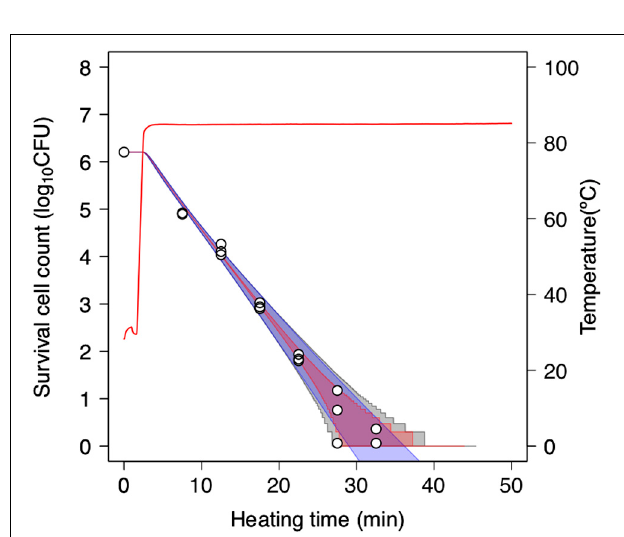
FIGURE 8 | Comparison of 99% confidence intervals derived from only-bootstrap model (blue region), only-MCMC model (red region), and 2DMC models (gray region) during heating at 85 ◦ C in pH-adjusted TSB at pH 5.4. The data points indicate two or three replicates of observed values. The only-bootstrap model is derived from the dynamic kinetic modeling of 1,000 secondary-model sets using the bootstrap method, while the only-MCMC model is derived from a dynamic stochastic secondary model constructed without application of the bootstrap